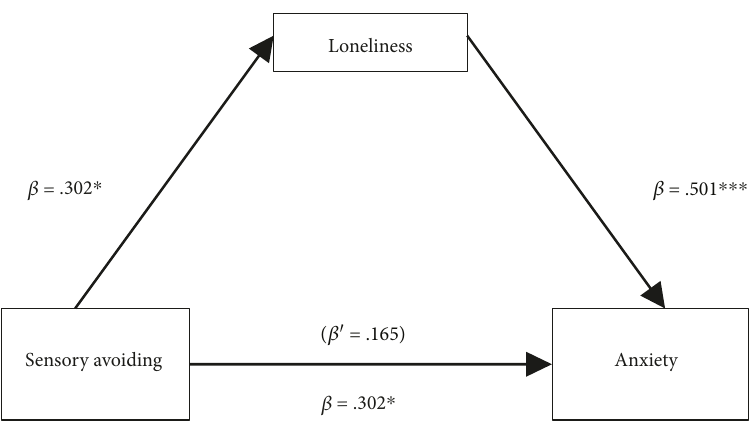
Figure 1: Results of testing for mediation by loneliness on relationship between sensory avoiding and anxiety. Note: ∗ p < 0 05 , ∗∗∗ p < 0 001 . β ’ referred to standardized coe ffi cient after controlling for anxiety. Type of mediation =full, Sobel ’ s z value =2.178, p = 0 0294 . Standardized coe ffi cient of sensory avoiding on anxiety: direct =0.165,